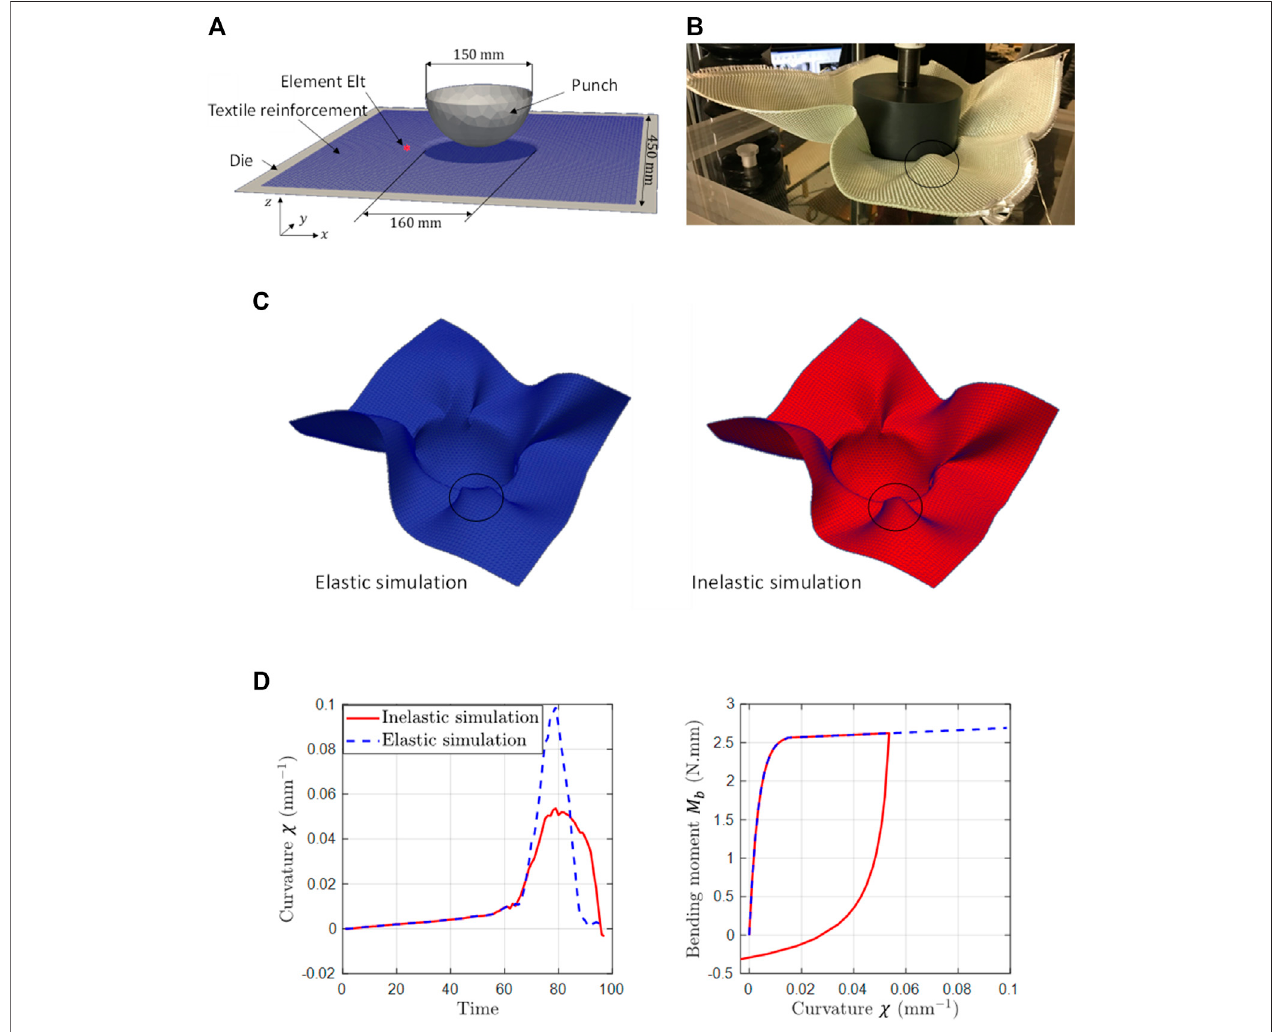
FIGURE 14 | Hemispherical forming (A) tool geometry, (B) experimental geometry of the deformed woven reinforcement, (C) numerical geometries obtained with elastic and inelastic behavior models, and (D) the curvature as a function of time and the bending moment as a function of the curvature of the element Elt.